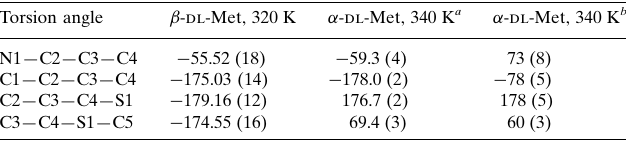
Selected torsion angles ( (cid:2) ). Torsion